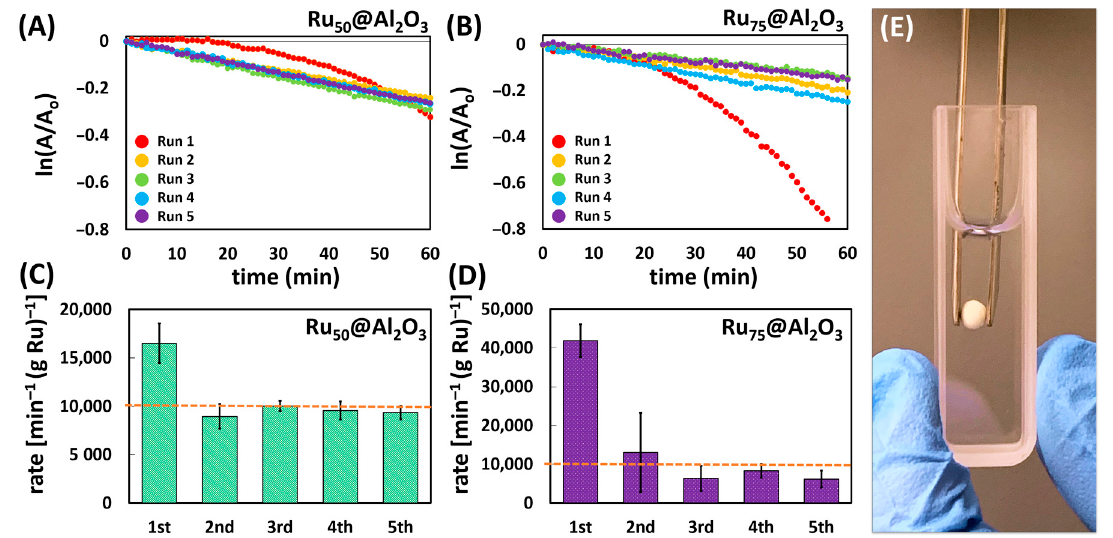
Figure 2. One 5-trial sequence of pseudo-first-order kinetics plotted for the reduction of 4NP using Ru 50 @Al 2 O 3 ( A ) and Ru 75 @Al 2 O 3 ( B ). Kinetic rates normalized to the mass of Ru over five trials for the Ru 50 @Al 2 O 3 ( C ) and Ru 75 @Al 2 O 3 ( D ); dashed line shown to facilitate rate comparison. ( E ) Photograph highlighting ease of